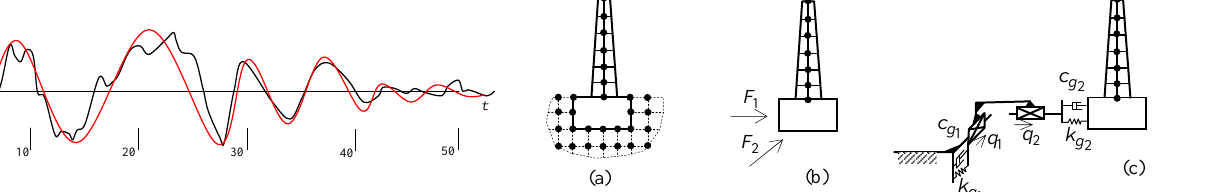
Figure 1. North-South displacement component of El Centro earth- quake, California, 1940. Figure 2. Modeling the ground-basement motion and force inter-